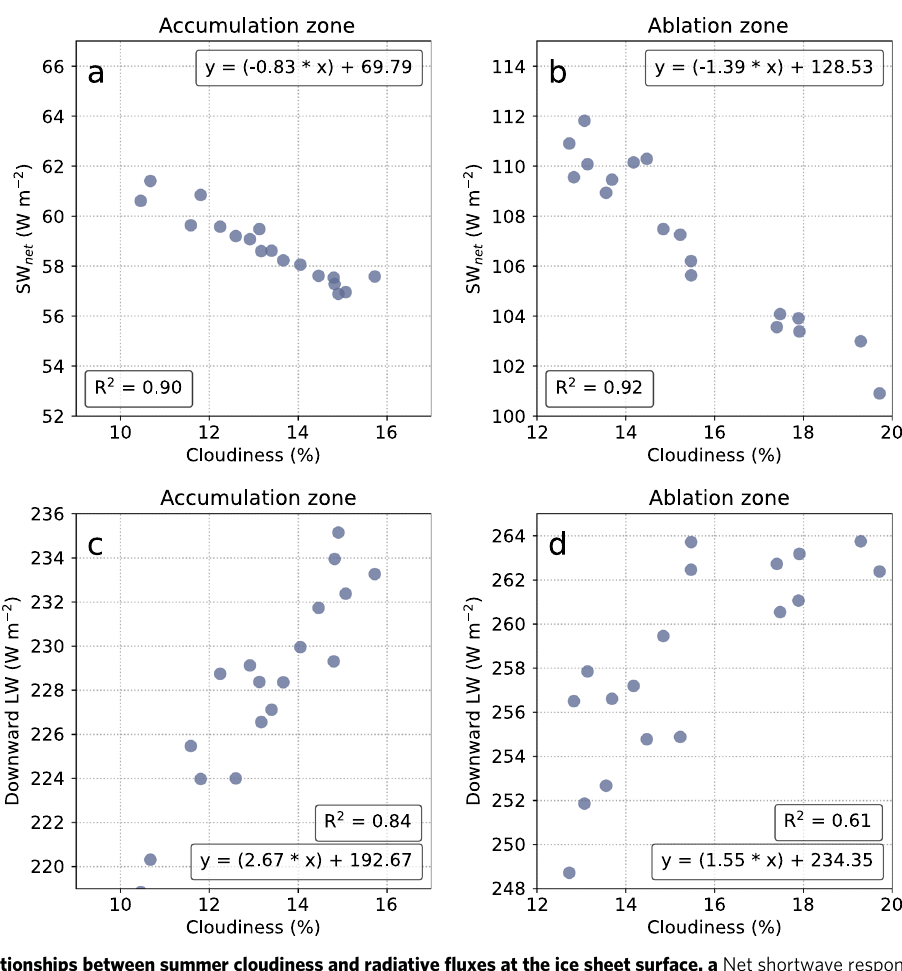
Fig. 2 Correlative relationships between summer cloudiness and radiative fl uxes at the ice sheet surface. a Net shortwave response to cloudiness in the accumulation zone, ( b ) Net shortwave response to cloudiness in the ablation zone, ( c ) Downward longwave response to cloudiness in the accumulation zone, ( d ) Downward longwave response to cloudiness in the ablation zone. Note that x and y axes are scaled to the same range. The slopes of these relationships signify the sensitivity of radiative fl uxes to changes in summer cloudiness.